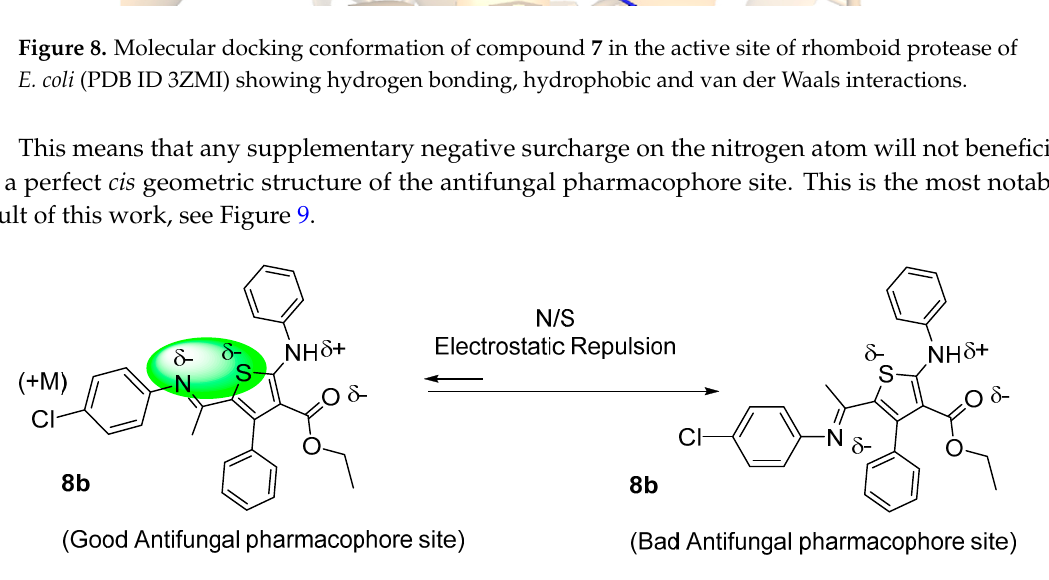
Figure 8. Molecular docking conformation of compound 7 in the active site of rhomboid protease of E. coli (PDB ID 3ZMI) showing hydrogen bonding, hydrophobic and van der Waals interactions.